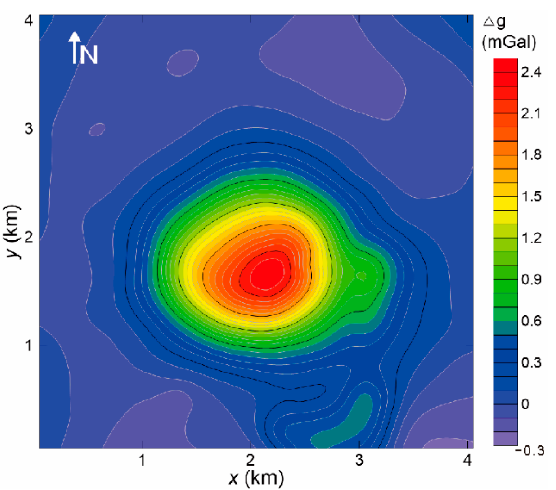
Figure 8. Field data subset from Vinton Dome area after trend surface removing and upward continuation (data courtesy of Scott Hammond from Bell Geospace).